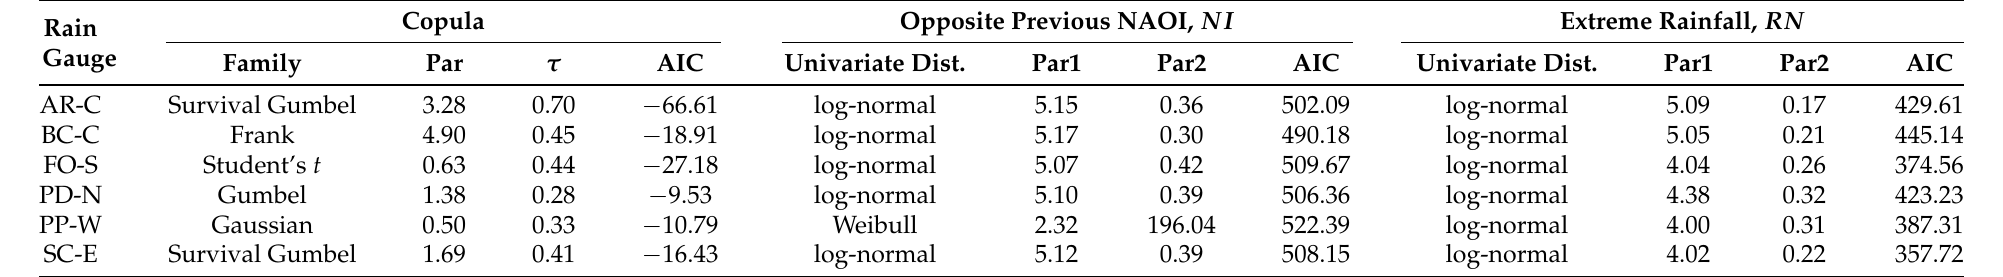
Table 4. Selected copula families, Kendall tau ( τ ), univariate distributions used for candidate of marginal distributions of NI and RN , and parameters of the models at each rain gauge. Par stands for the copula parameter, and Par1 and Par2 for the marginal distribution